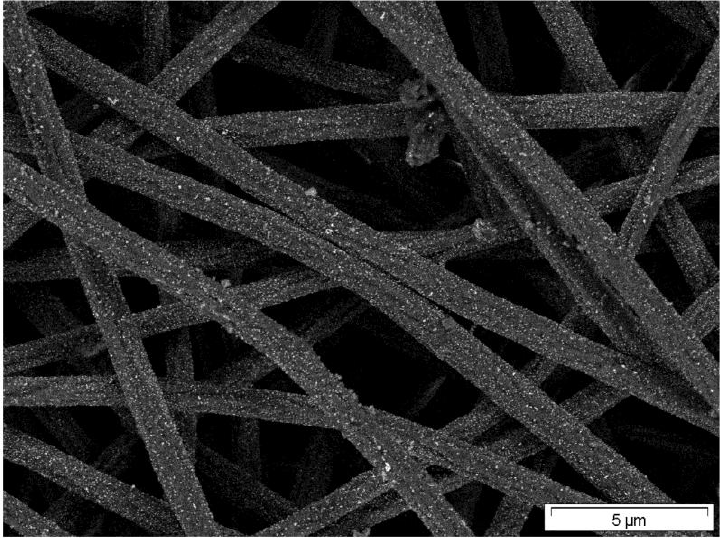
Figure 10. Formation of a bionanohybrid structure through adsorption of Au nanoparticles onto the BSA/PANGMA nanofibers. (Reprinted with permission from [110]. Copyright 2012 Wiley-VCH Verlag GmbH & Co. KGaA).